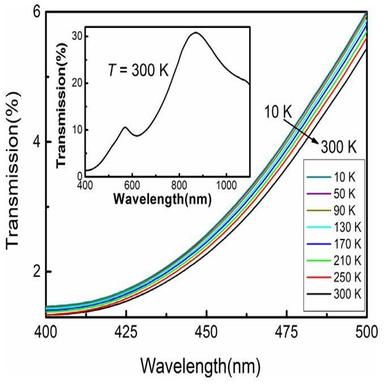
Transmission spectra of CZSe thin films at different temperatures between 10 and 300 K. Inset shows the full spectrum detected between 400 and 1100 nm at 300.